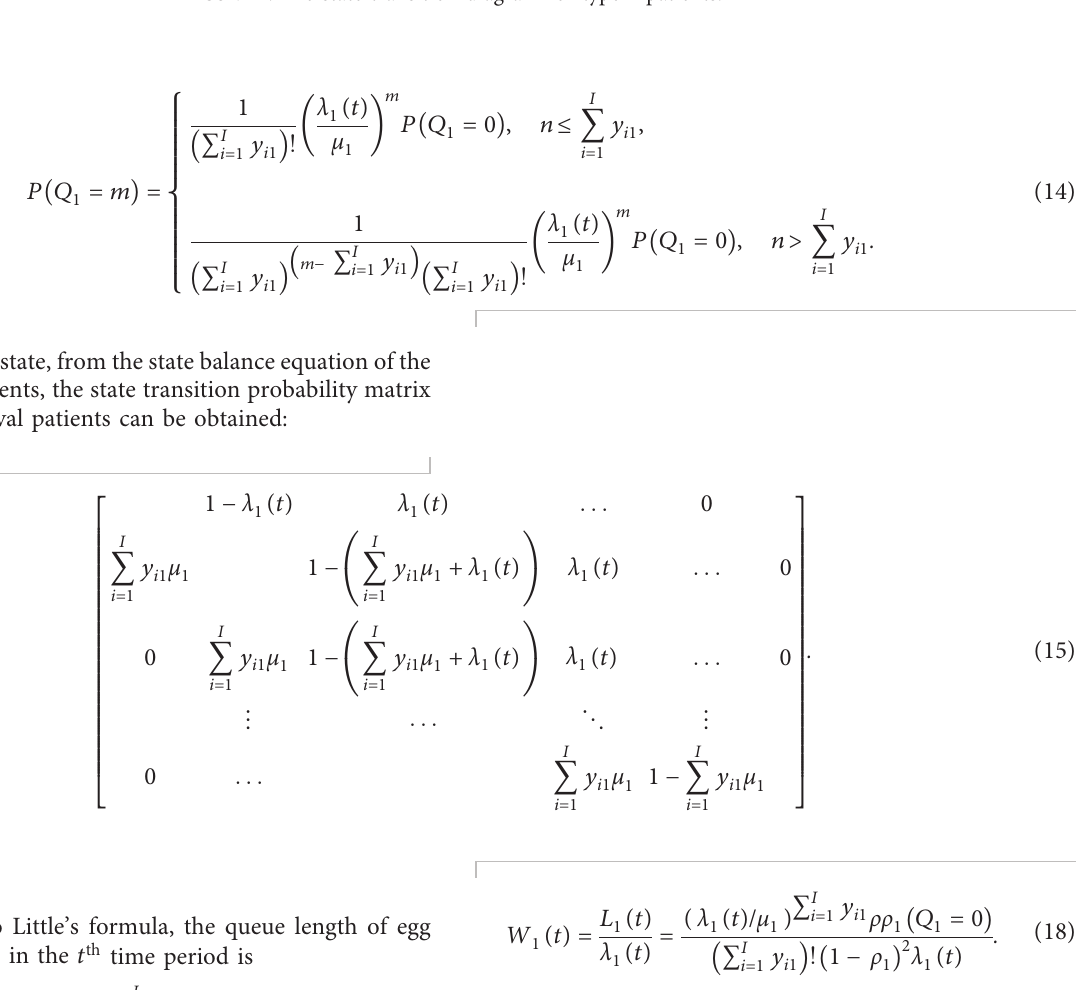
Figure 4: The state transition diagram for type 1